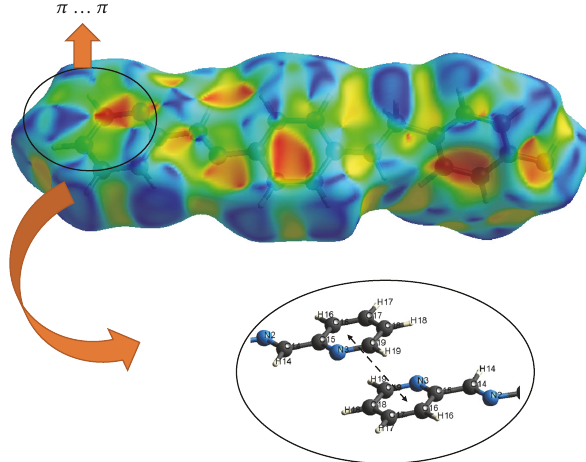
Figure 10: View of the shape index surface for EPAF showing the highlighted 𝜋 ... 𝜋